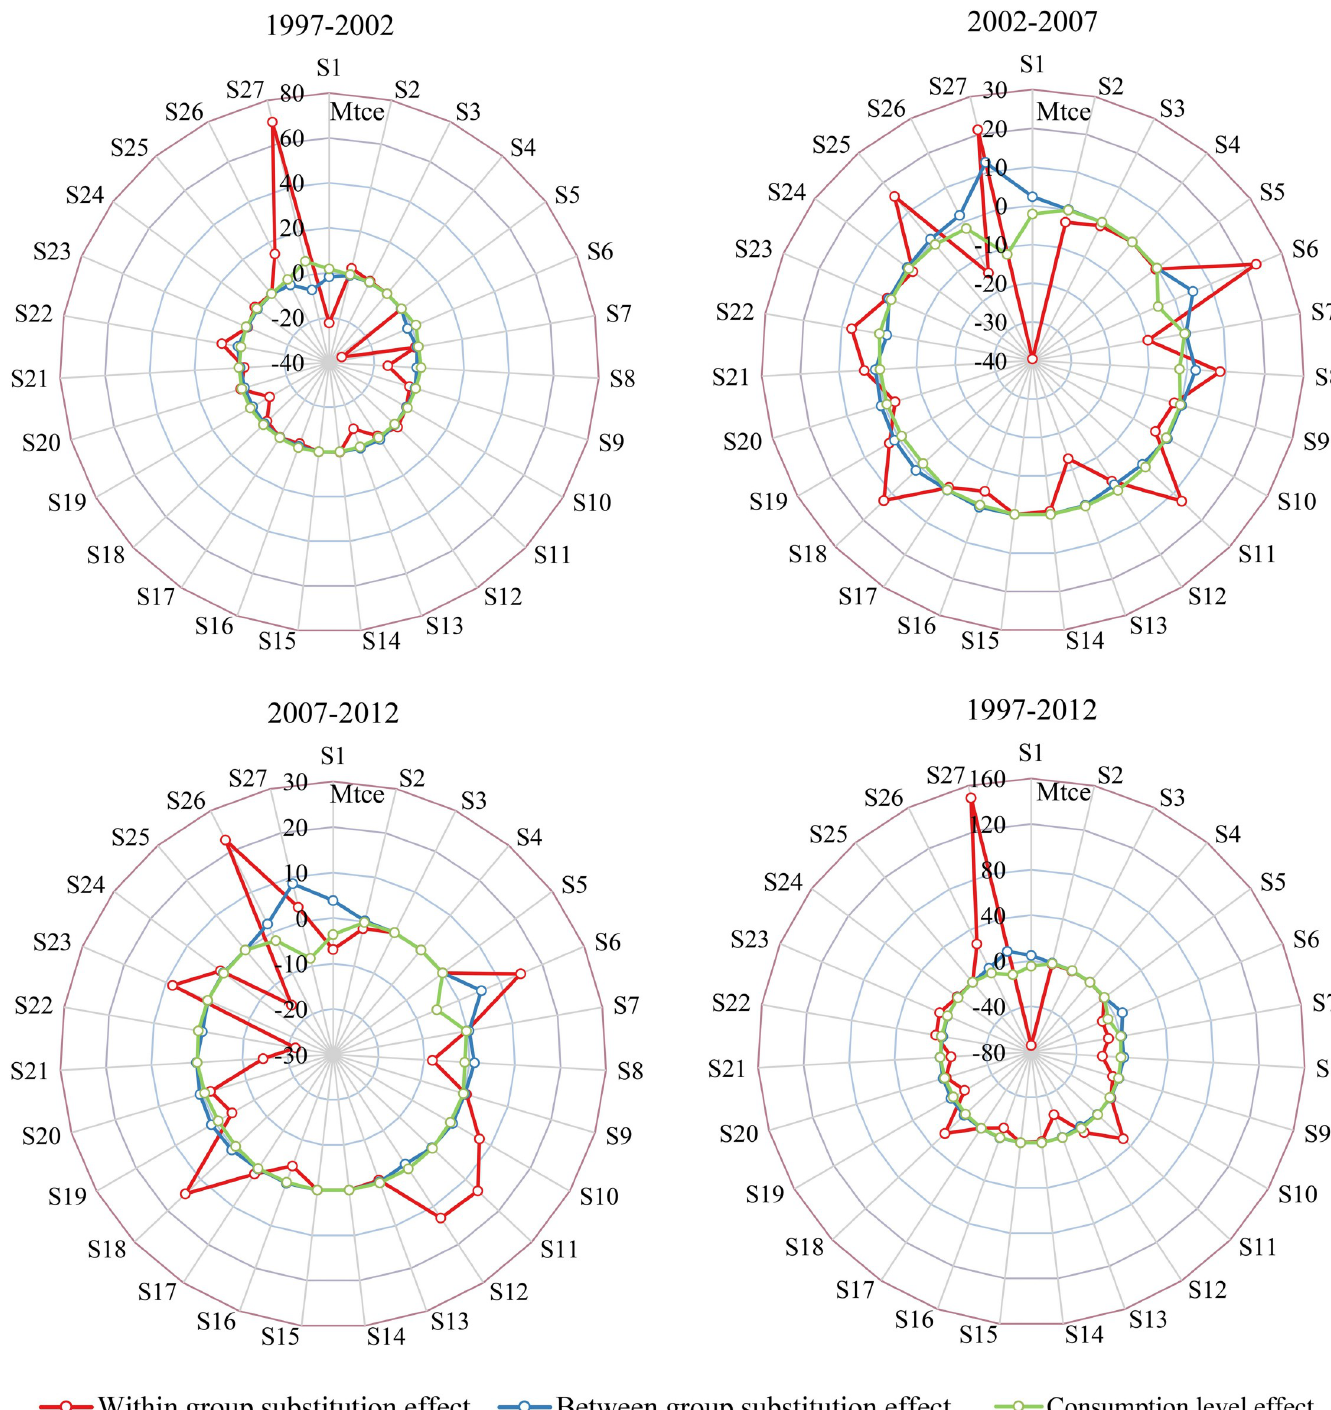
Fig 4. Comparison of consumption-related effect contributions to sectoral household indirect energy consumption changes between 1997 and 2002, 2002 and 2007, 2007 and 2012, and 1997 and 2012.